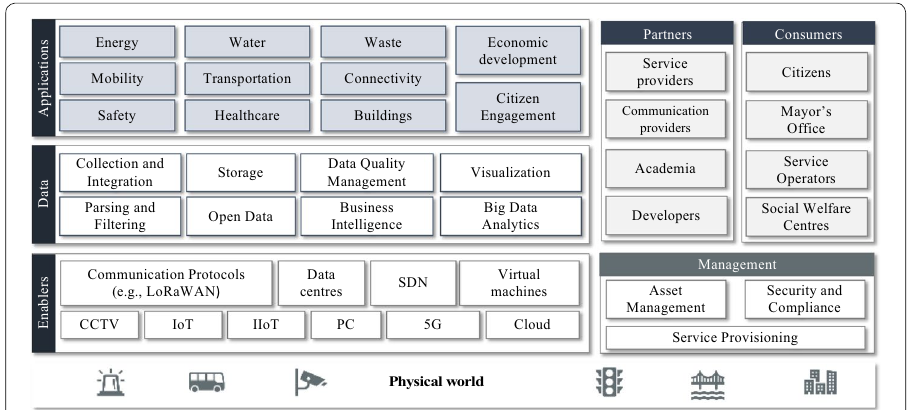
Fig. 2 A high‑level architecture of smart cities with different operational